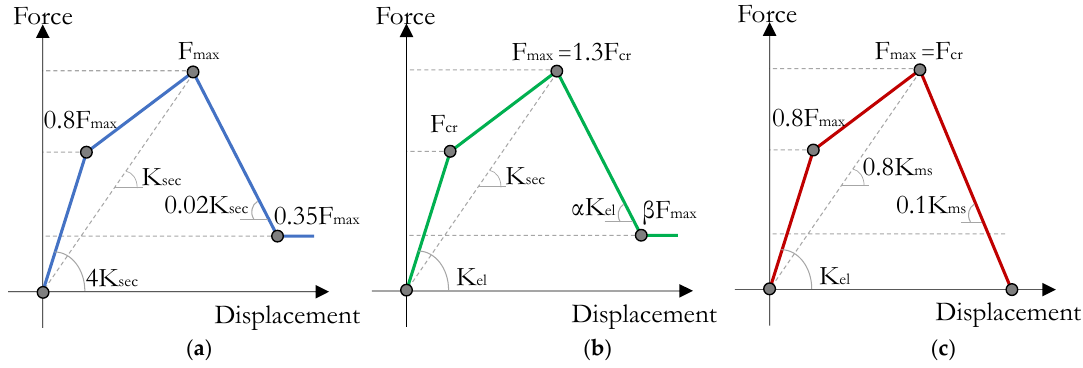
Figure 4. Example of backbone curves: ( a ) Bertoldi et al. [18], ( b ) Panagiotakos and Fardis [16] and ( c ) De Risi et al. [14].